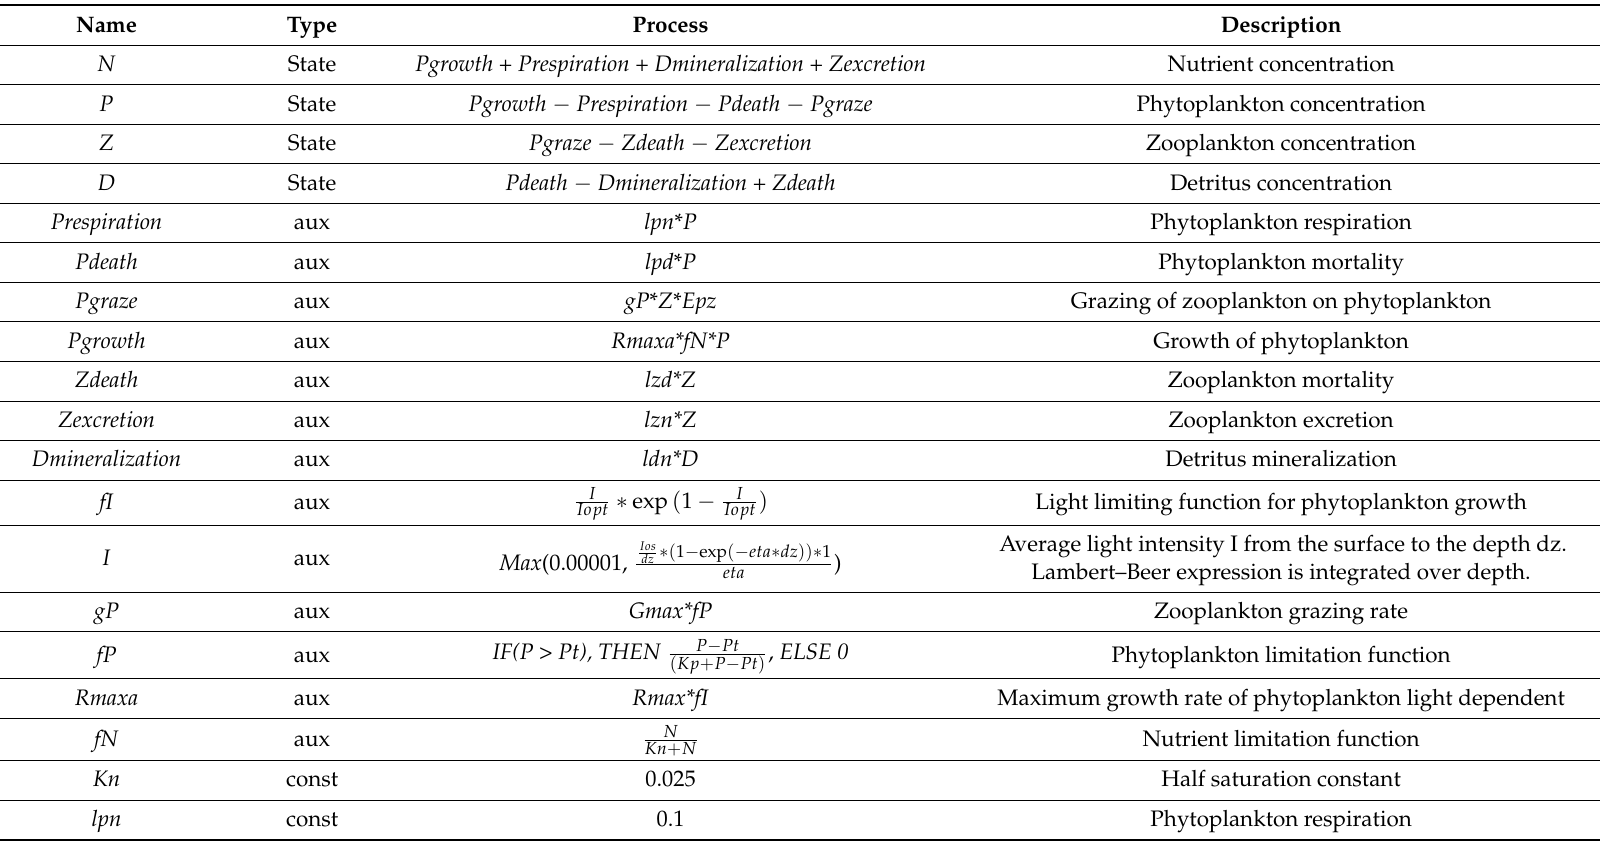
Table 2. State variables, processes, and constants of the two-dimensional NPZD model. “Type” refers to the type of the variable/process. “State” refers to the variables whose concentrations are being calculated at each time t by using auxiliary processes. Concentrations at time t of state variables can be used in auxiliary processes to calculate the concentration at t + 1; “aux” refers to auxiliary processes, which are intermittent processes calculated in order to calculate the concentration of the state variable. Auxiliary processes cannot include circular references, any additional auxiliary process used need to have been defined before. “Const” refers to constant values, which are provided to the model prior to the simulation, such as the half saturation constant. “Forcing” refers to external variables provided to the model, such as a file of PAR concentrations for each time t of the simulation. The depth forcing is provided from the hydrodynamic model for each grid cell and time t of the